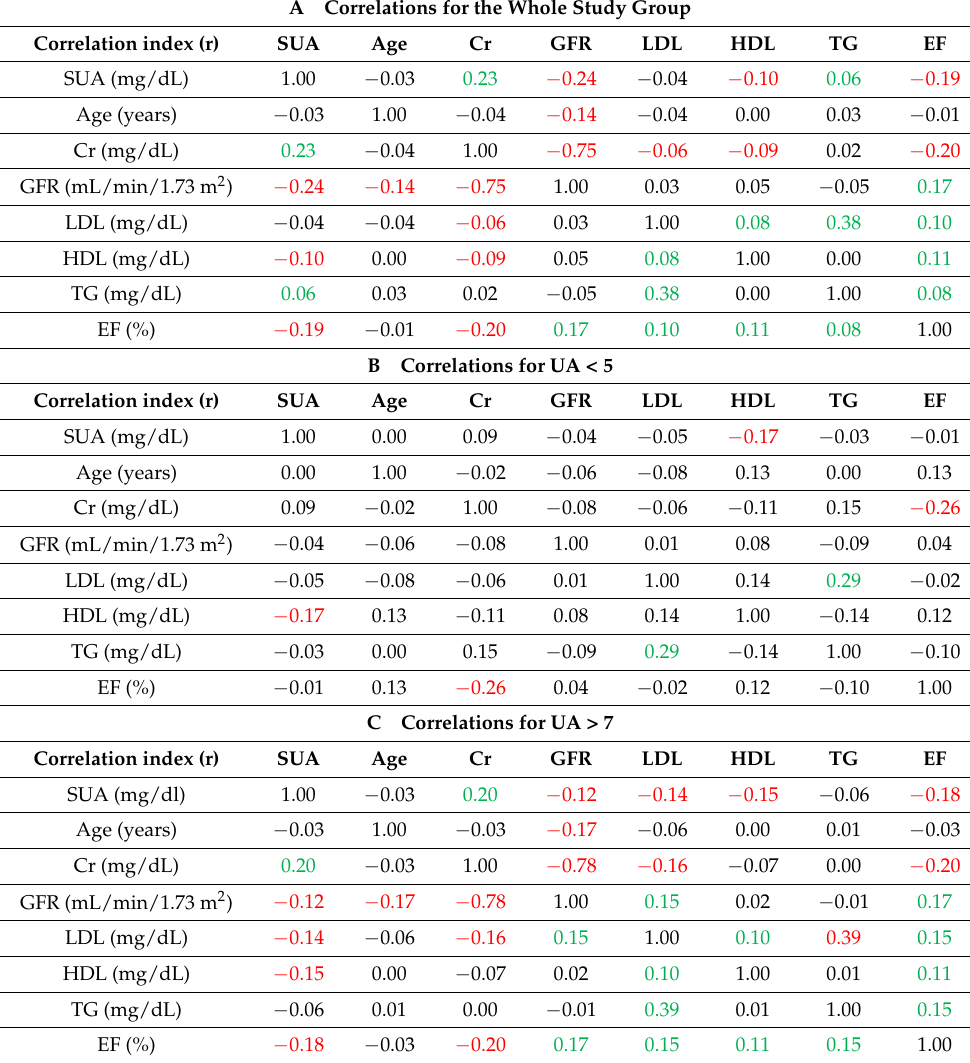
Table 3. ( A – C ). Results of correlation analysis of the whole group ( A ) and of subgroups with low SUA ( B ) and high SUA ( C )